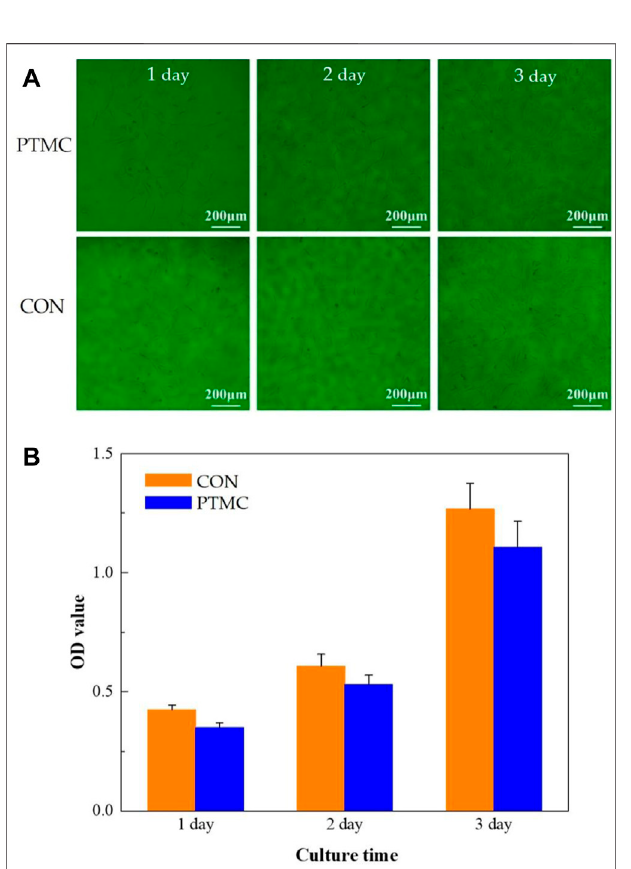
FIGURE 2 | The morphology (A) and proliferation (B) of MC3T3-E1 cells cultured in PTMC extracts.